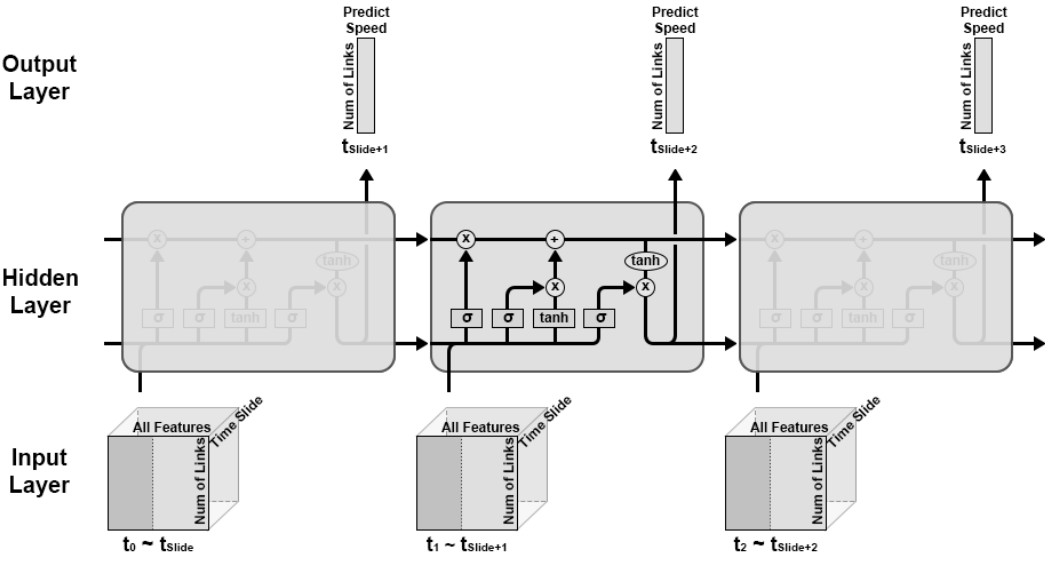
Figure 9. Using LSTM for modeling the correlation between the temporal patterns and the speed prediction at every time window.